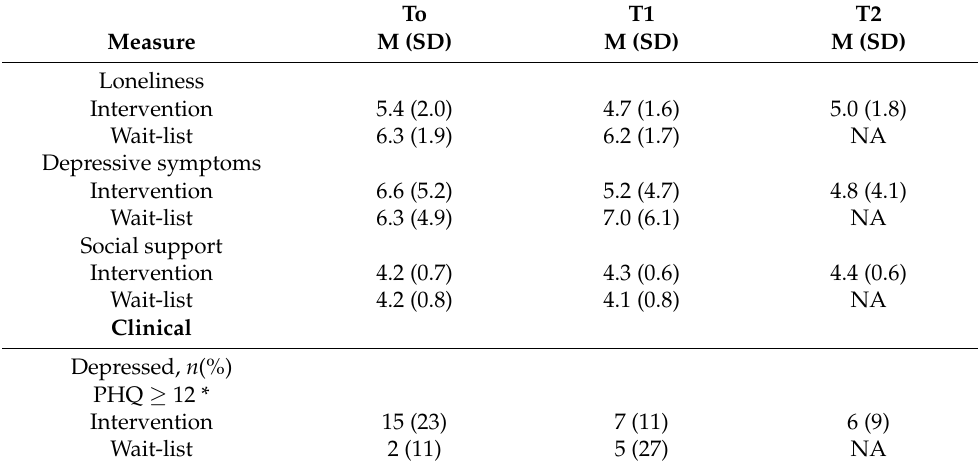
Table 2. Primary outcomes at T0, T1, and